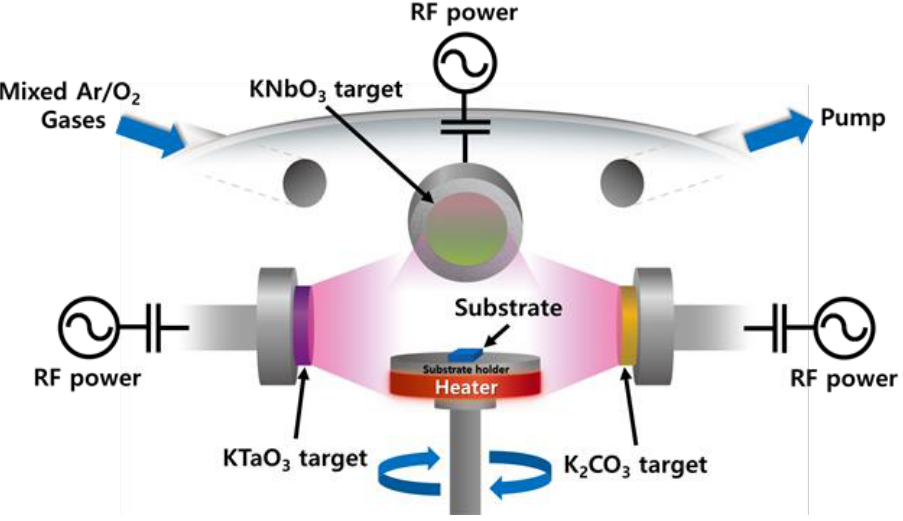
Figure 1. Schematic diagram of the home-built off-axis sputtering system equipped with 3 sputtering guns and RF power sources. Table 1. Deposition parameters of RF magnetron co-sputtering for KTN thin films.